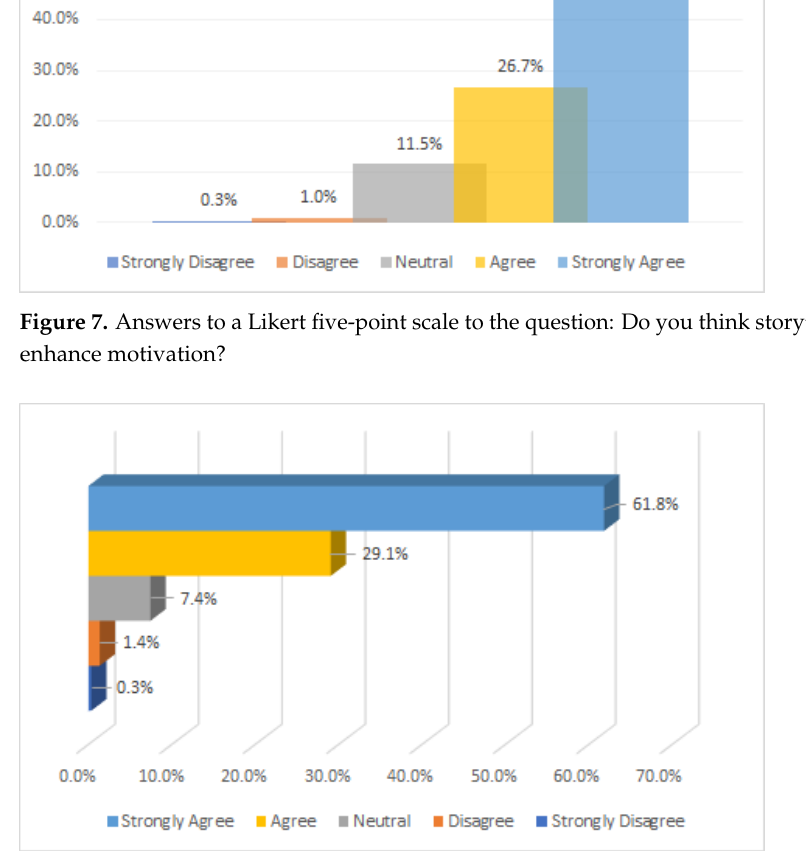
Figure 8. Answers to a Likert five-point scale to the question: Do you think storytelling has promote a positive-emotion